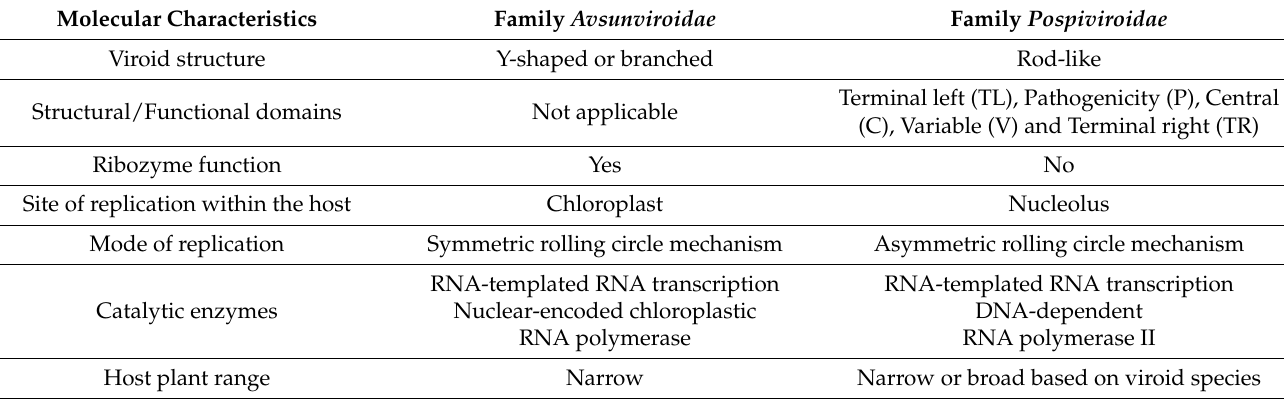
Table 1. Molecular features of viroids considered for classification.